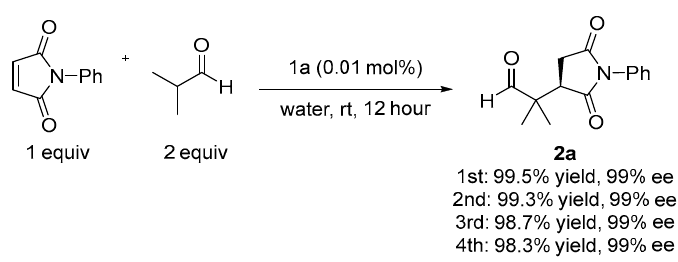
Figure 7. Gram-scale reaction of N -phenylmaleimide and isobutyraldehyde and catalyst recycling through catalyst recovery.